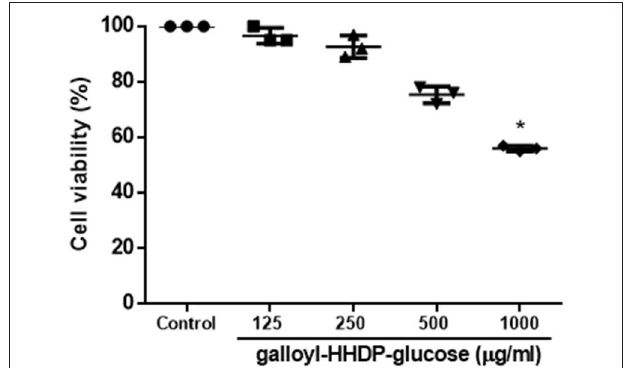
FIGURE 8 | Effect of Galloyl-HHDP-glucose for cell viability of RAW 264.7 cells. Results are expressed as means followed by standard deviation of three independent experiments performed in triplicate. (*) indicates statistically significant different compared to control group by Kruskal–Wallis followed by Dunn multiple comparison test